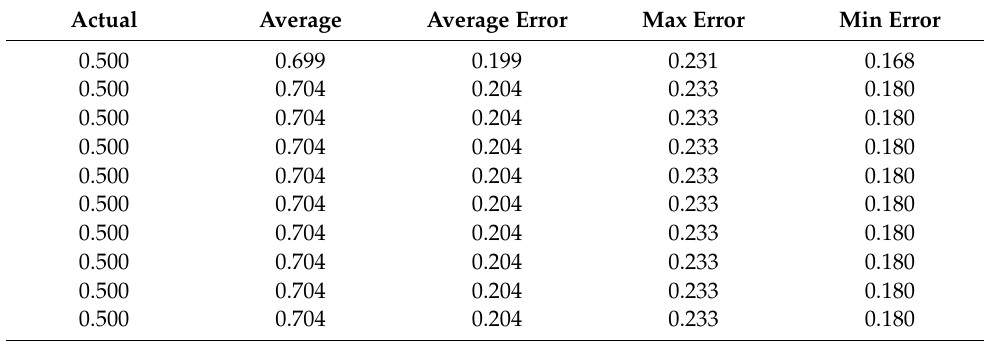
Table A19. Set 1, trials 11–20 data (all 0.5 PR values).